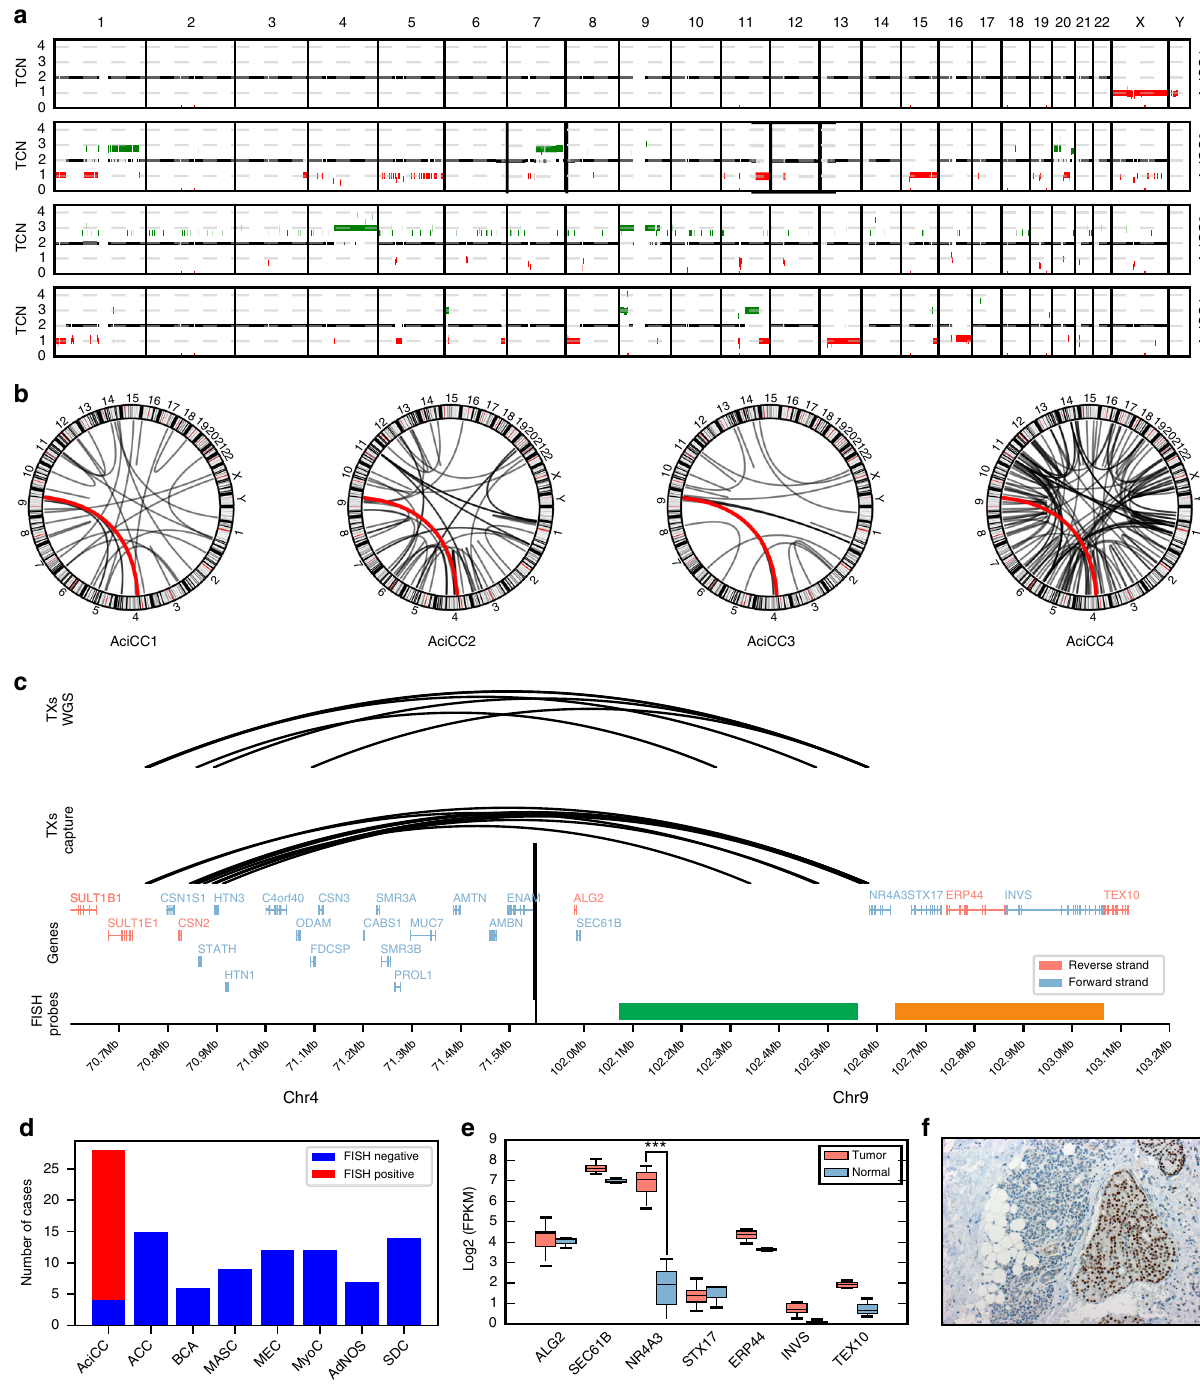
active H3K27ac/H3K4me3 and repressive H3K27me3 chromatin marks at the 9q31 locus upstream of the NR4A3 TSS and very-low DNA methylation levels at the promoter region in the normal parotid tissue, indicating a bivalent/poised promoter (Fig. 2 right panel). Comparing three AciCC samples with normal parotid tissue, the chromatin marks, as well as DNA methylation patterns were overall well-preserved in the tumors, with slightly lower repressive H3K27me3 chromatin marks at the NR4A3 promoter region and lower DNA methylation levels at the NR4A3 gene body in two samples. ChIP-seq for NR4A3 binding sites revealed several peaks at the SCPP gene cluster in the tumor tissues that NATURE COMMUNICATIONS| (2019) 10:368